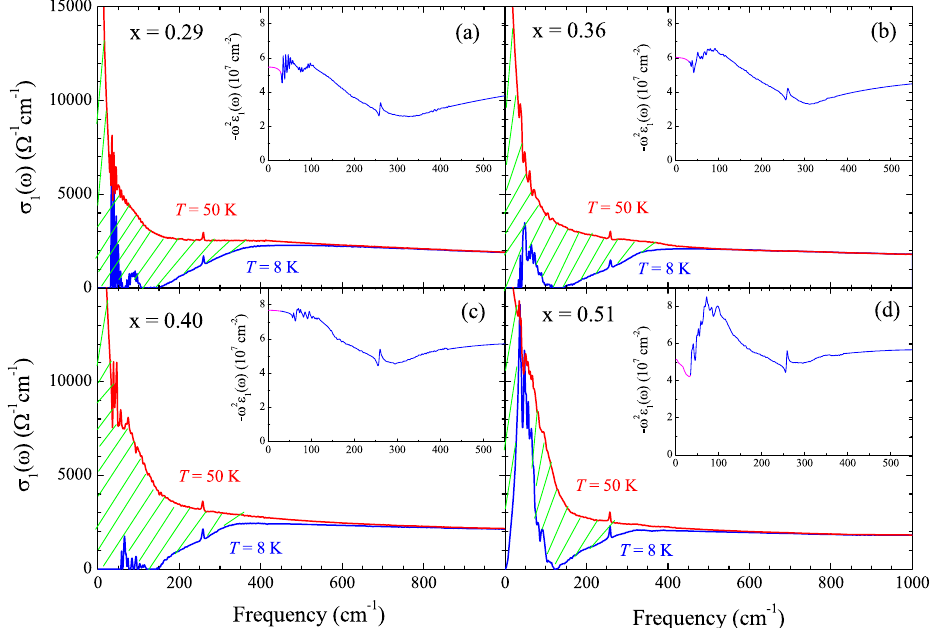
Figure 3. (Color online) Optical conductivity spectra of K-doped Ba-122 at two temperatures: 8 K (SC state) and 50 K (normal state); ( a ) x functions of ω are